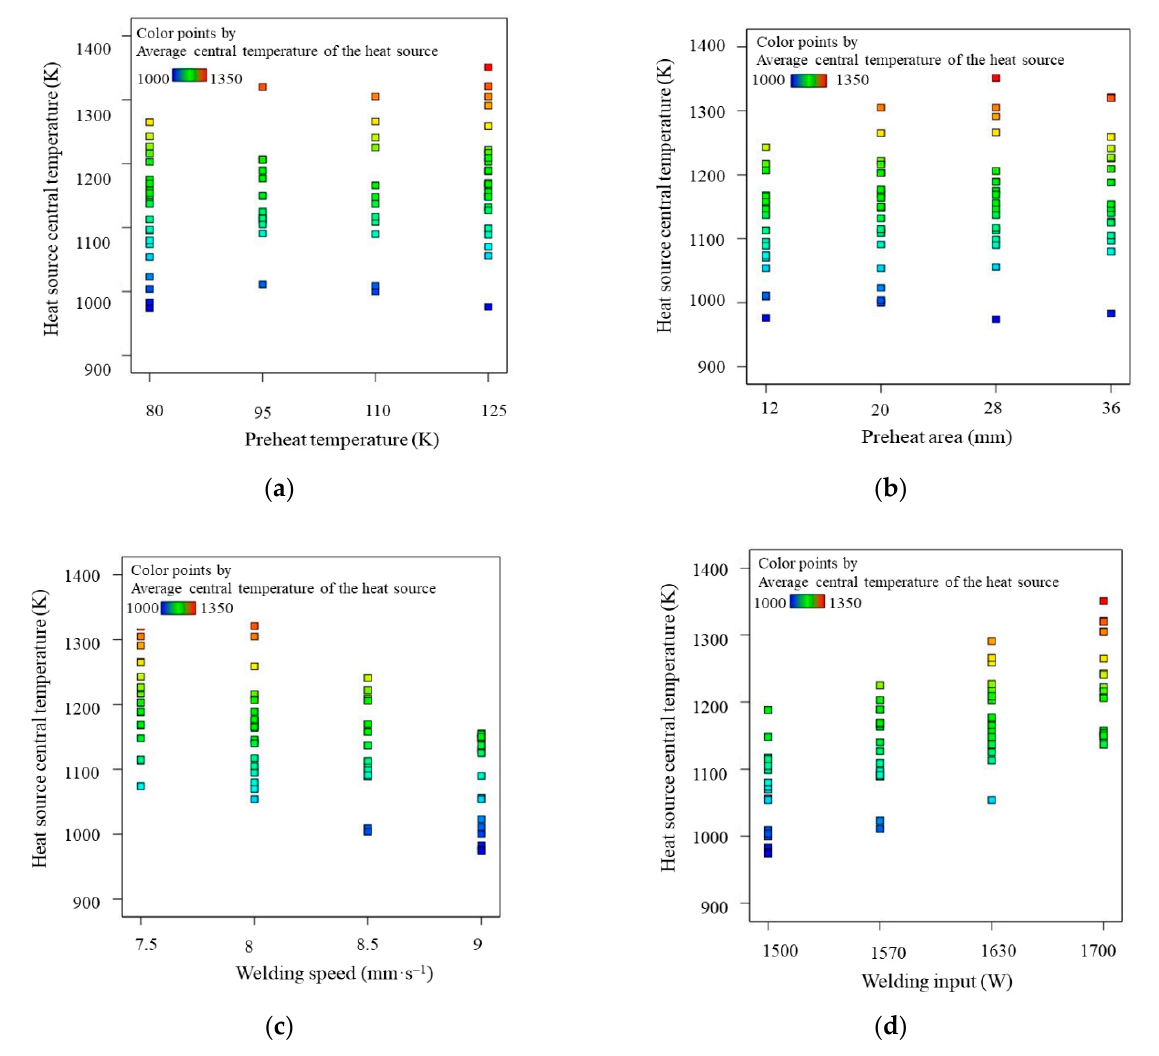
Figure 9. The influence of different process parameters on the average central temperature of the heat source. ( a ) The influence of preheat temperature; ( b ) the influence of preheat area; ( c ) the influence of welding speed; ( d ) the influence of welding input.